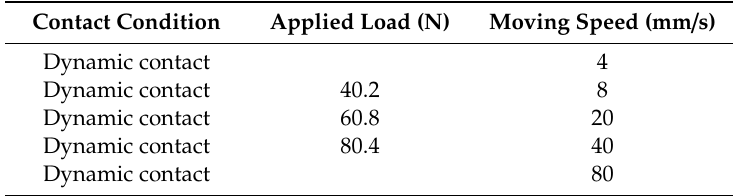
Table 4. Experimental conditions for dynamic contact.